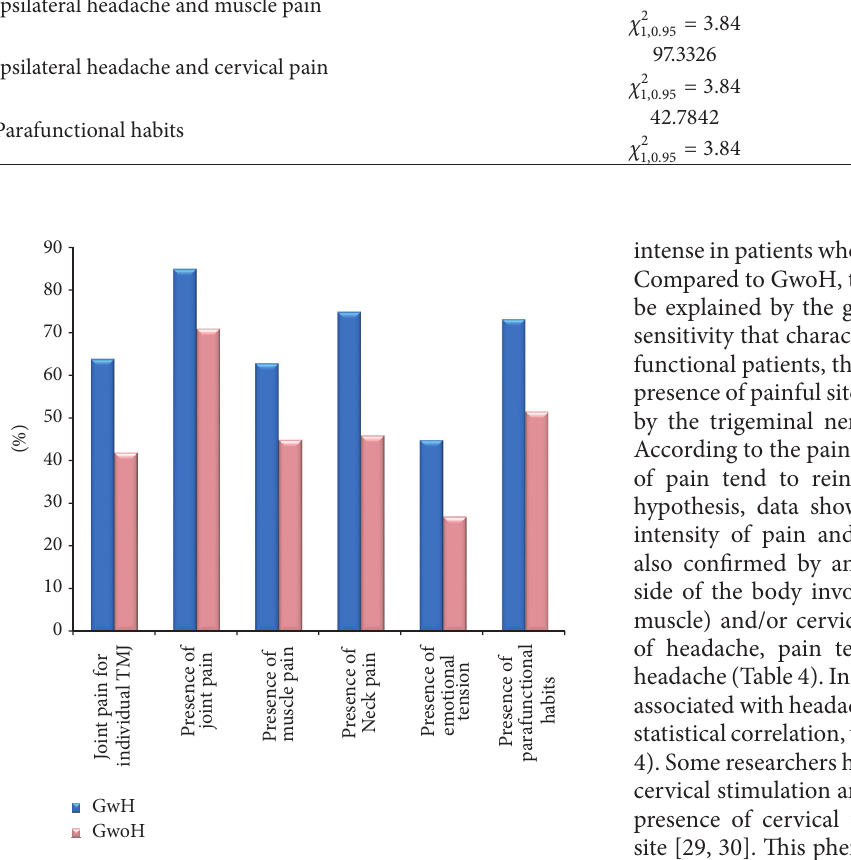
Figure 2: Percentage (%) values of prevalence of painful variables (joint pain for individual TMJ, presence of joint pain, muscle pain, and neck pain), emotional tension in the previous 6 months, and parafunctional habits in Group with Headache (GwH) and Group without Headache